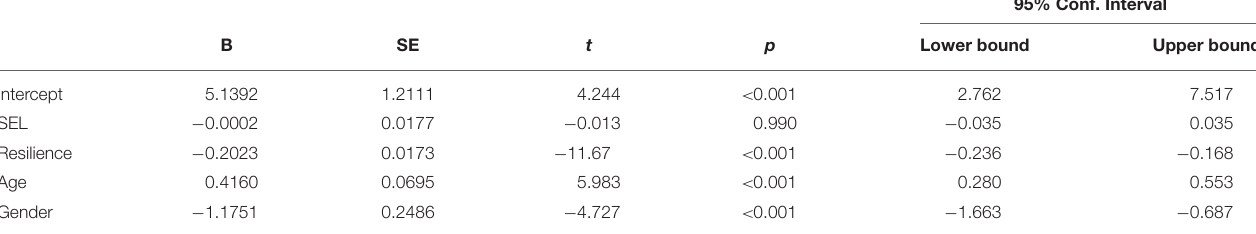
TABLE 2 | Regression outcomes for the target variable Internalizing